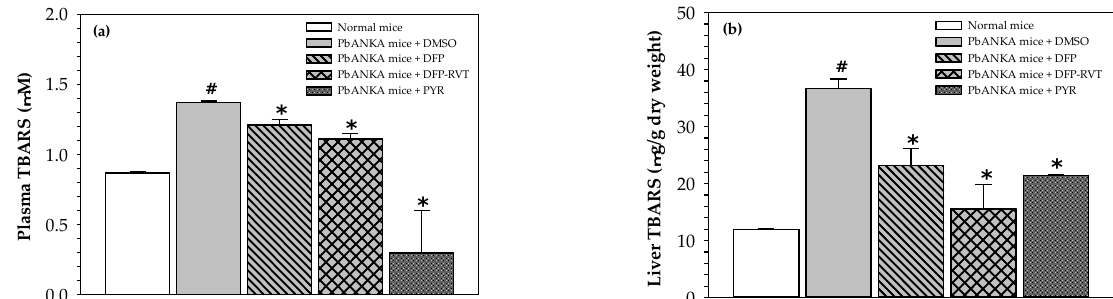
Figure 3. Levels of TBARS in plasma and liver tissues collected from normal mice and PbANKA-infected mice treated with DMSO, DFP, DFP-RVT and PYR. Male ICRmice were infected ip with PRBC suspension (1 × 10 7 cells/mL with 5–20% parasitemia), then orally administered with 60% DMSO, PYR (2 mg/kg BW), DFP (50 mg/kg BW) and DFP-RVT (50 mg/kg BW) every day for 4 d. The mice were then humanely euthanized. Heart blood was collected into lithium heparin-coated tubes and plasma was separated for determination of TBARS concentration ( a ). Livers were removed, homogenized and TBARS concentrations were determined ( b ). Data are expressed as mean ± SEM values. # p < 0.05 when compared to normal mice; * p < 0.05 when compared to PbANKA mice treated with DMSO.